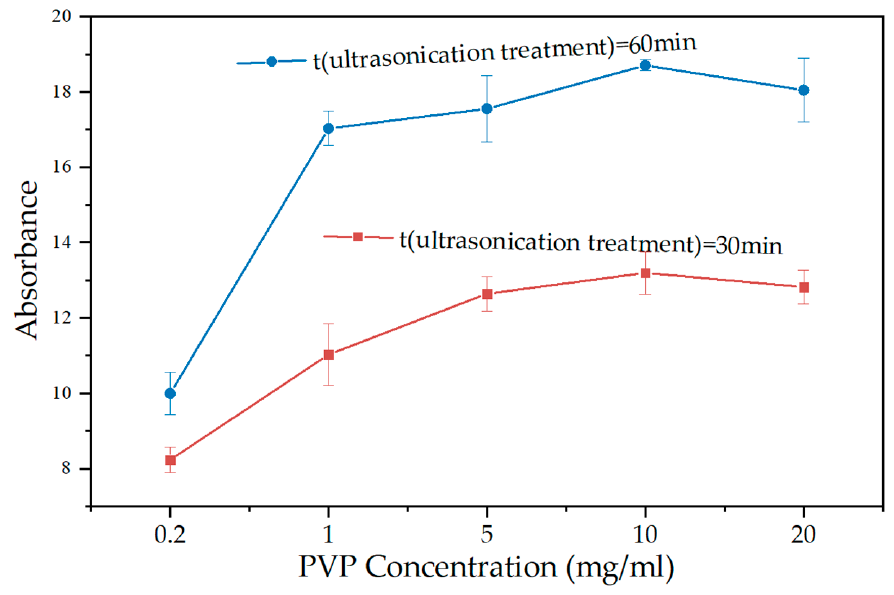
Figure 2. Absorbance of GNPs suspension at different PVP concentrations.